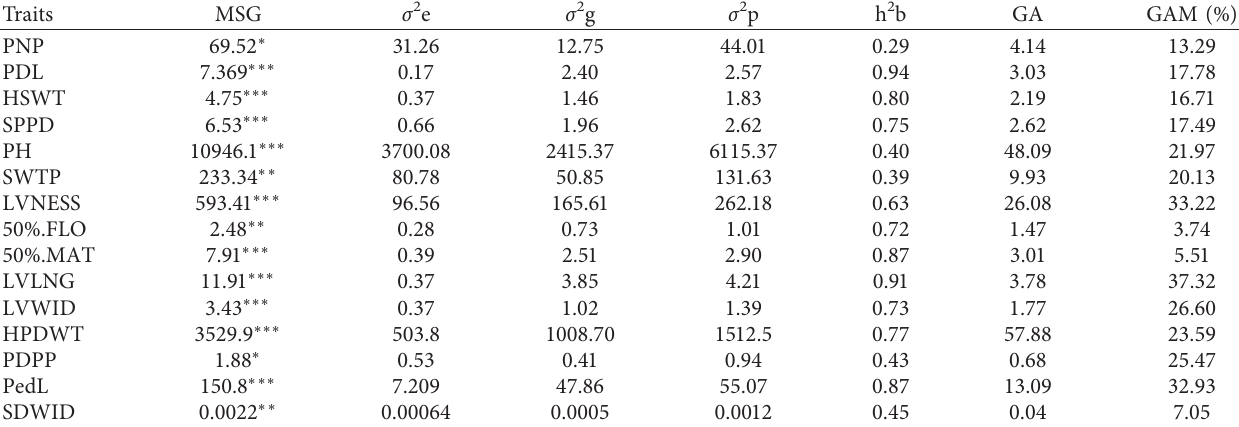
Table 4: Estimates of variance components and genetic parameters for the quantitative traits.